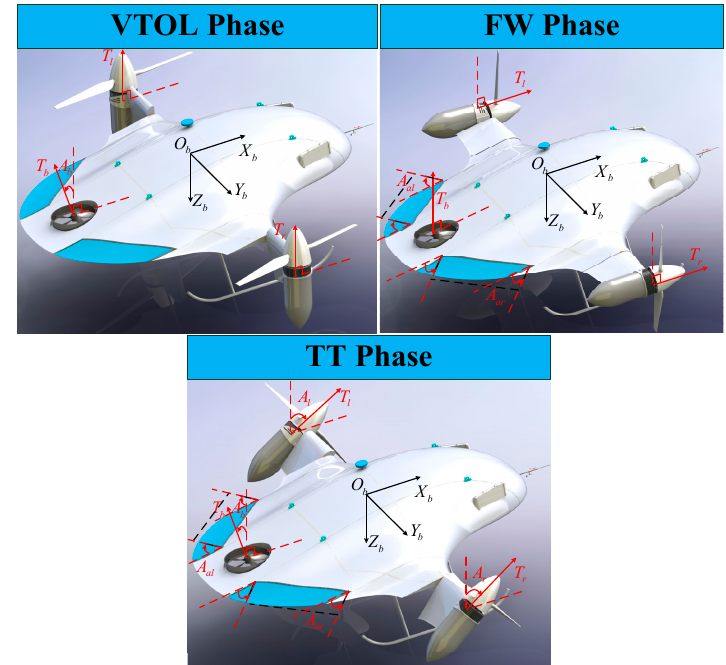
Figure 1. The flight phase of the novel tilt-rotor UAV. Currently, the conventional control scheme of the underactuated system has been applied to the control system design of most tilt-rotor aircraft, in which the attitude inner loop controls the position outer loop, and the vertical altitude control loop is added [12,13]. In dynamic modeling, the common rotorcraft modeling approach is used, where the attitude is assumed to be stable and constant, and the effect of changing the attitude on the UAV’s stability and safety during take-off and landing is ignored. There is no more accurate control scheme based on the multi-actuator properties of tilt-rotor UAVs [14,15]. However, the oceanic operation of an aircraft is subject to a more severe environment than its land operation. The control difficulties and risks are extreme for the shipboard UAV in the VTOL phase, as the area of the shipboard is limited, the wind is not uniform, and the shipboard motion occurs in roll, pitch, and heave [ Error! Reference source not found. ,17]. At the same time, the UAV with a blended wing body layout has a longer wing. When crosswinds are present, and a conventional control scheme is adapted for landing, a roll angle is required to balance the aerodynamic forces due to the sideslip. This approach obviously increases the risk of the wing tips hitting the shipboard surface [18]. tilting transition process, and the control strategy is the same as in the VTOL phase [19]. of the UAV needs to be changed, which leads to a more complex interference of the UAV